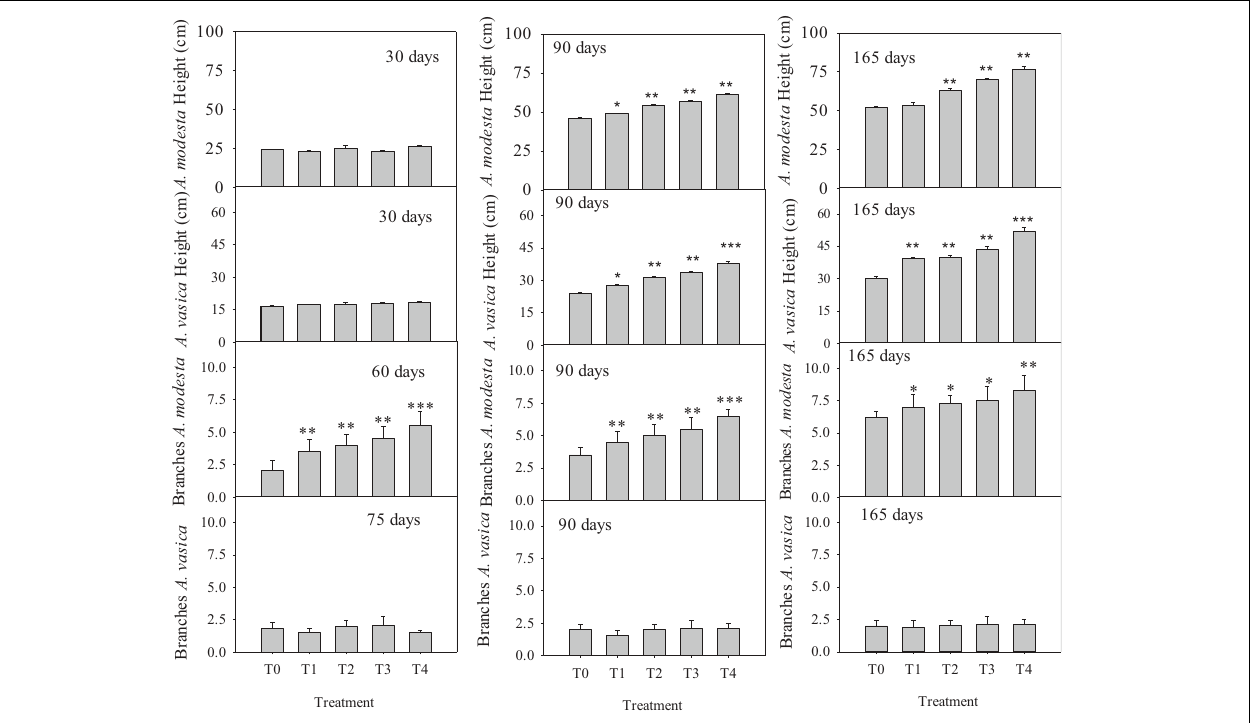
FIGURE 3 | Effect of quarry waste on plant height (cm) and number of branches per plant in Acacia modesta and Adhatoda vasica during the initial months, middle months, and before the harvest. The asterisk indicate the significant difference of treatment means with the control ( T 0 ): ∗ P < 0.05, ∗∗ P < 0.01, and ∗∗∗ P < 0.0001.